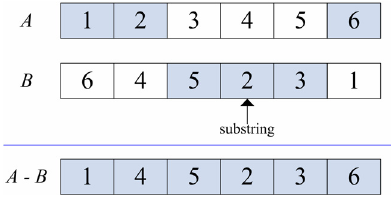
Fig. 6. Illustration of the redefined subtract operator ( − )